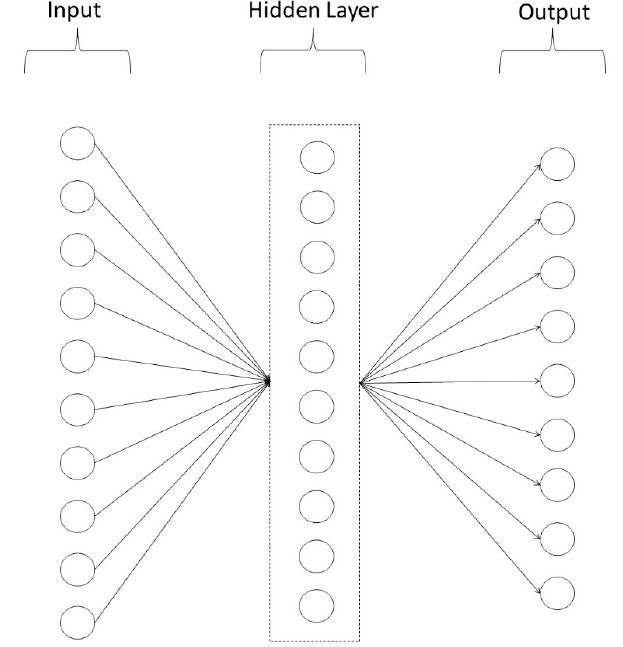
Figure 2. Lower-level Psychopathology Artificial Neural Network Model. Note . Depiction of the lower-level psychopathology artificial neural network model used in this research. The first layer of the model contains 10 input units consisting of age, gender, and the eight neurocognitive tasks. The second layer is the hidden layer consisting of 10 units. The final layer is the output layer consisting of nine output units, namely depression, agoraphobia, mental fog, interpersonal anxiety, somatisation, hostility, alcohol, cannabis, and other substances.